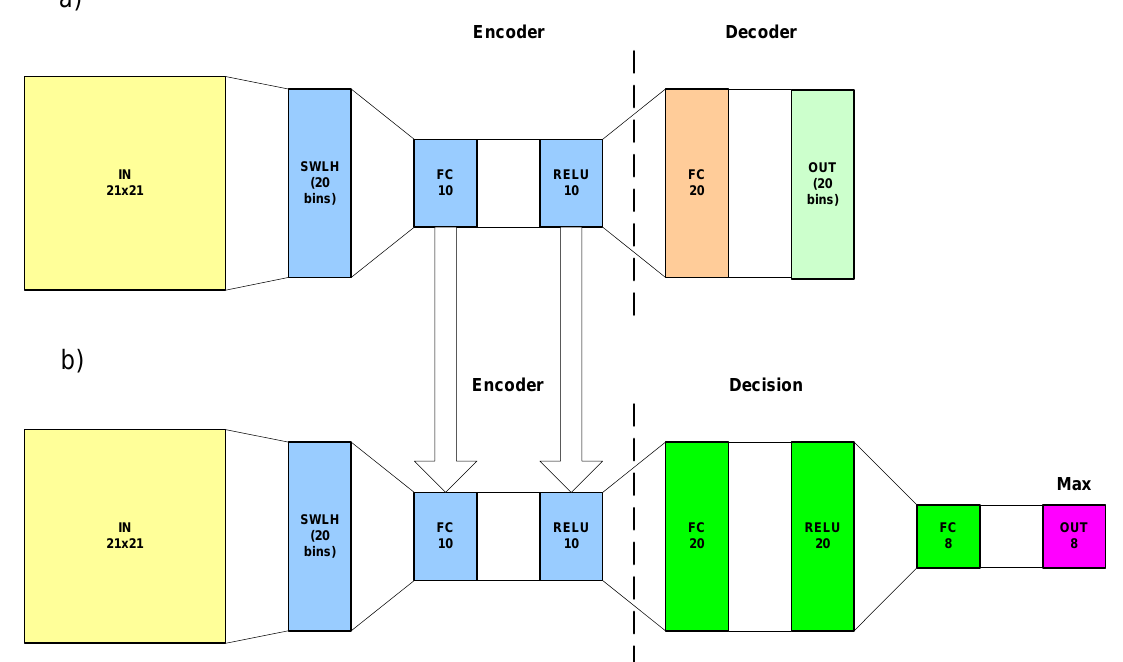
Figure 4. Scheme of HistAENN architecture for both training phases (RELU—REctified Linear Unit Layer, FC—Full Connection Layer) (( a ) autoencoder phase, ( b ) classifier